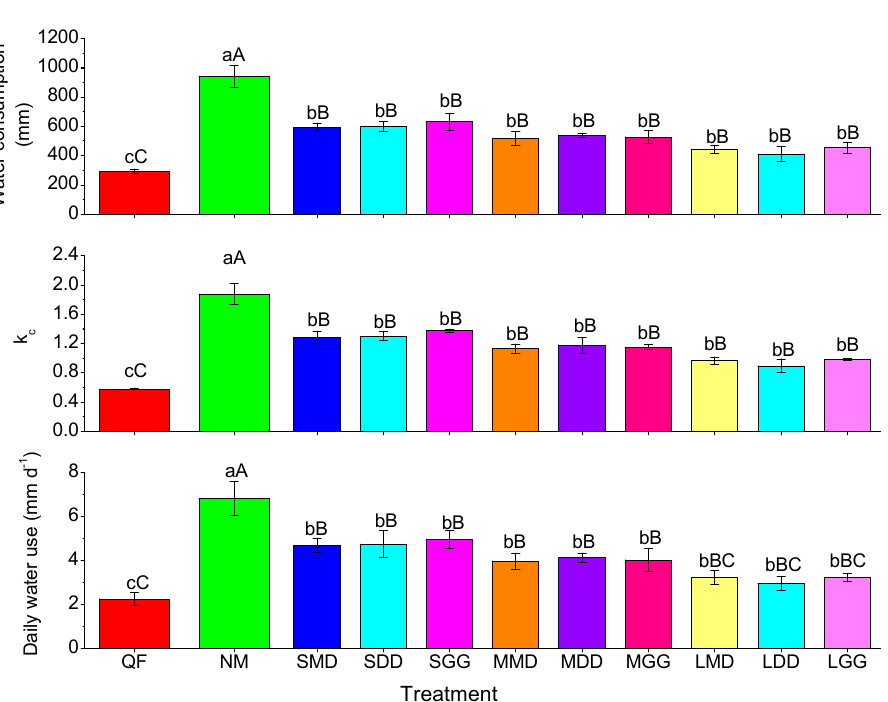
Figure 4. ET c , reference crop coefficiency ( k c ), daily water use changes in April–September 2017. QF represents RFPS with film mulching on both ridges and furrows, without water supply after seed emergence; MD represents RFPS with film mulching on continuous ridges; DD represents RFPS without film mulching; GG represents conventional flat planting no film mulching; NM refers to local sufficient irrigation (actual irrigation amount excessively exceed water needed). S refers to high water supply level (650 mm), M refers to moderate water supply level (500 mm), and L refers to low water supply level (400 mm) (the same below). Values represent means ± SE ( n = 12). Bars labeled with different letters (lowercase, capital) differed remarkably among the treatments ( p ≤ 0.05, p ≤ 0.01). The maize growing period with QF, MD, and DD was shorter than with NM by approximately